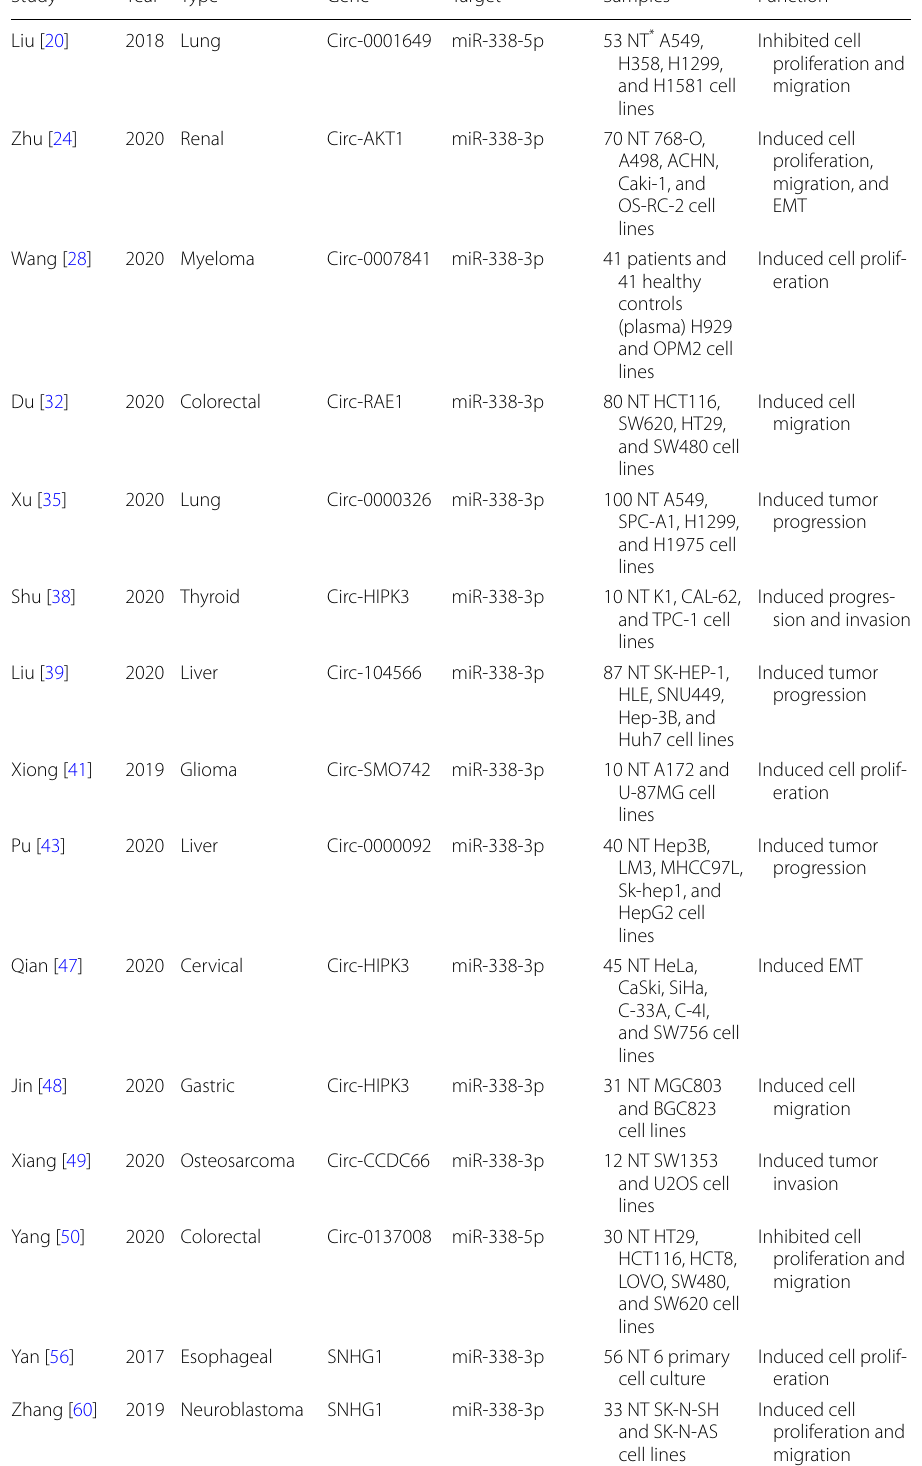
Table 1 molecular targets of miR-338 during tumor progressions